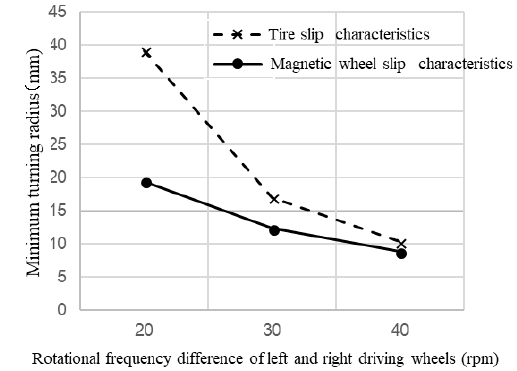
Figure 11. Comparison between tire slip characteristics and magnetic wheel slip characteristics. The dotted line shows the results of tire slip characteristics. The solid line shows the results of magnetic wheel slip characteristics.